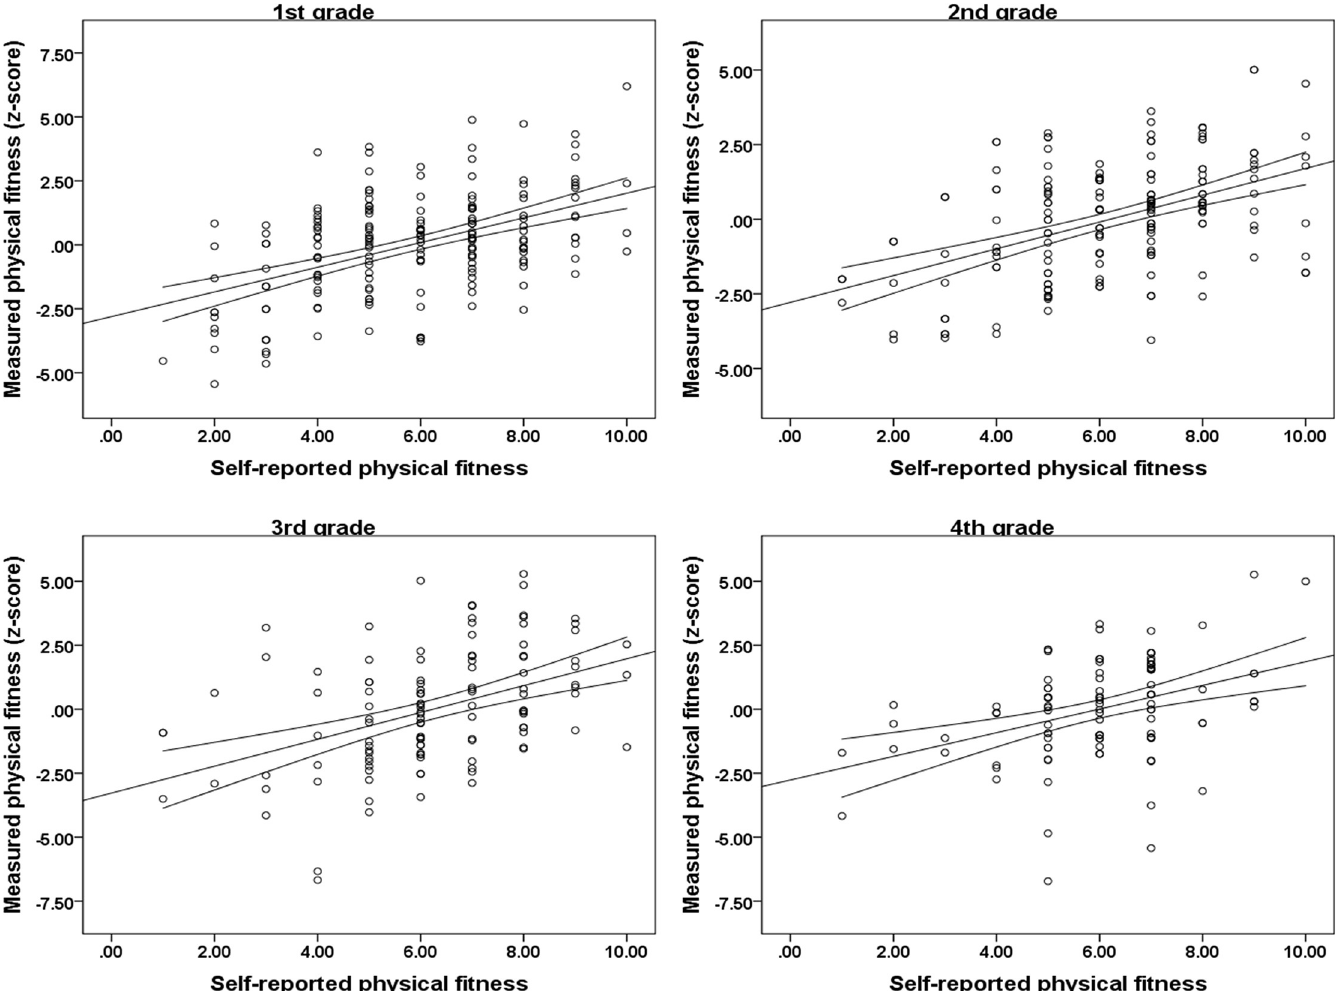
Fig 2. Age specific correlations between self-reported (x-axis) and measured (y-axis) physical fitness in girls (Croatia, 2019).